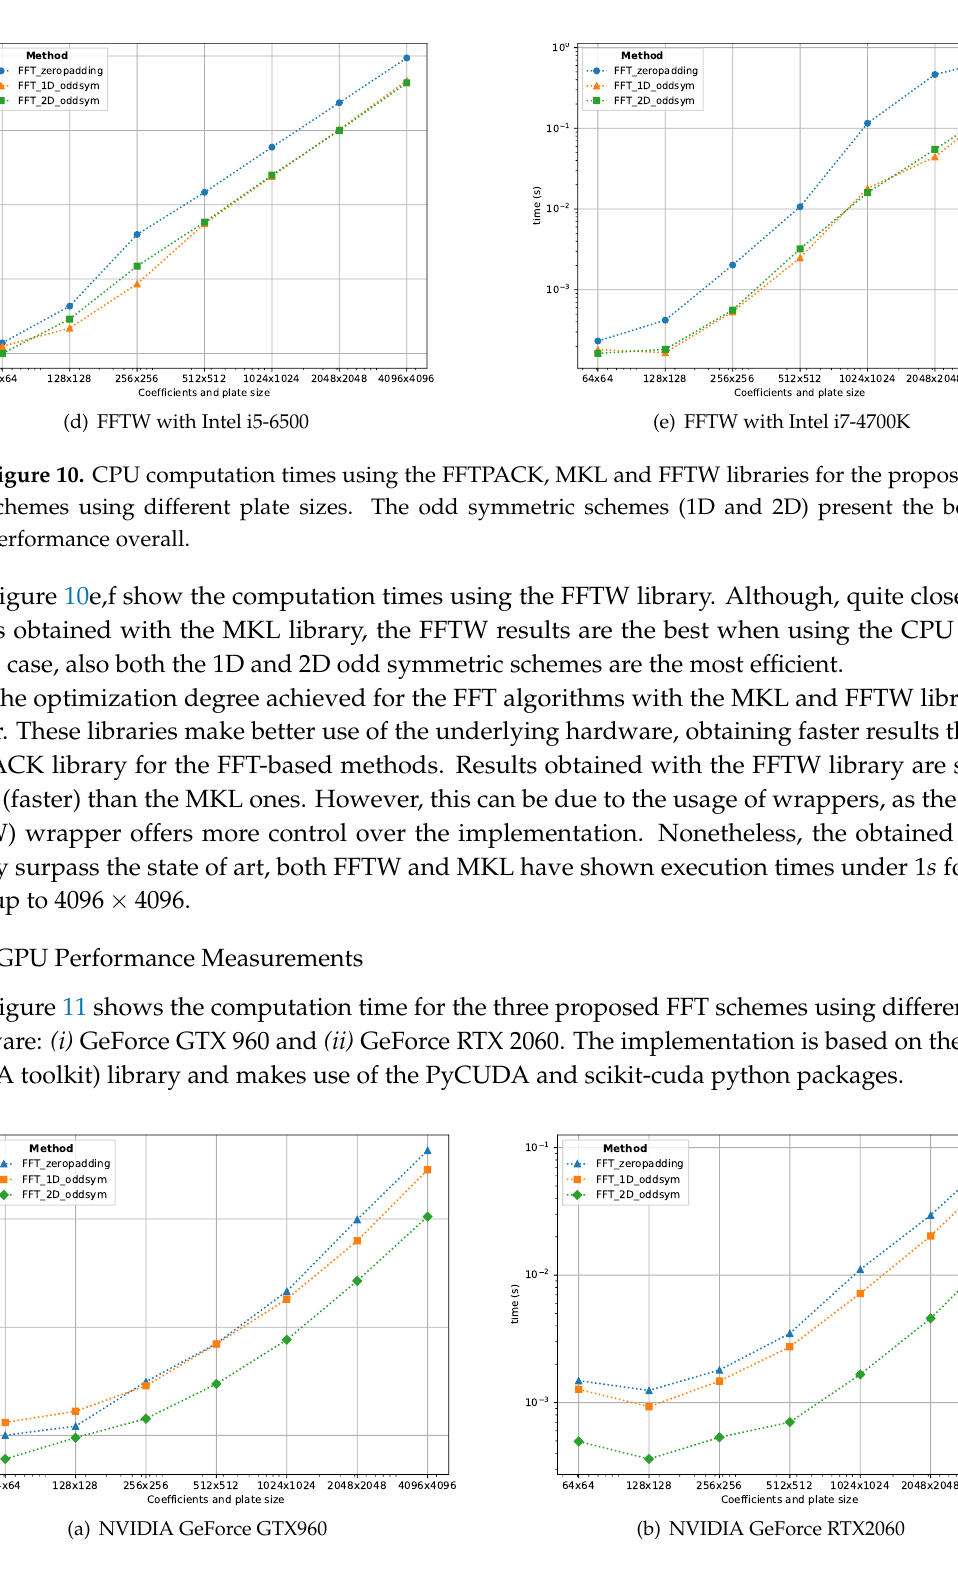
Figure 11. GPU computation times for the FFT-based methods using the cuFFT library with different plate sizes. The 2D odd symmetric scheme outperforms the remainder FFT-based